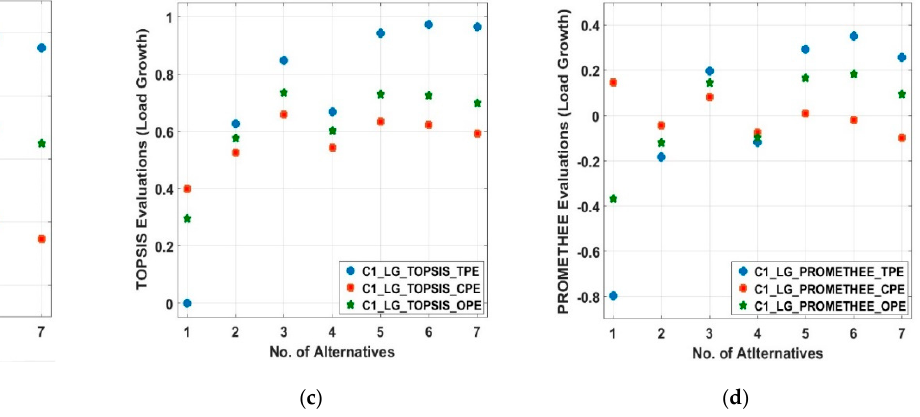
Figure 9. MCDM evaluations for C1_LG in 33-bus MDN: ( a ) WSM scores; ( b ) WPM scores; ( c ) TOPSIS scores; ( d ) PROMETHEE scores.